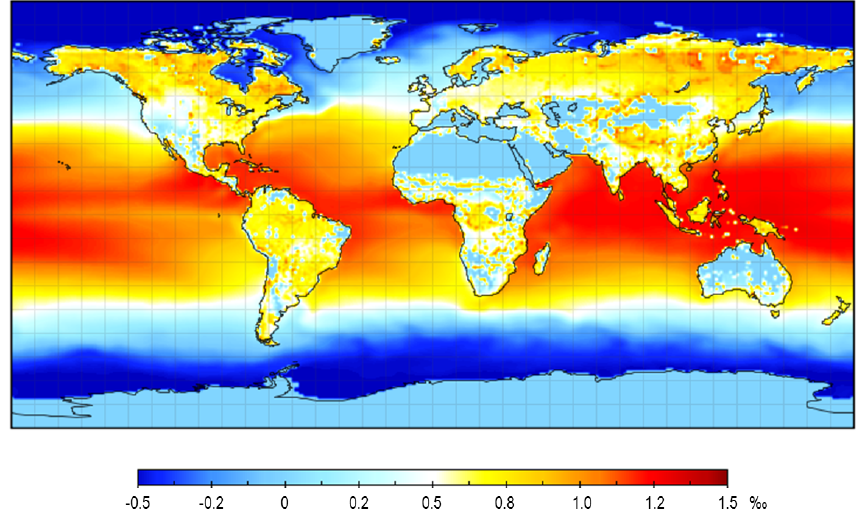
Figure 6. Disequilibria between 13 C fluxes to and from the land or ocean surface in 2000. At the land surface, the disequilibrium is the differ- ence between photosynthetic and respiratory discriminations against 13 C, and at the ocean surface it is the difference in 13 C discrimination between the one-way diffusive downward and upward